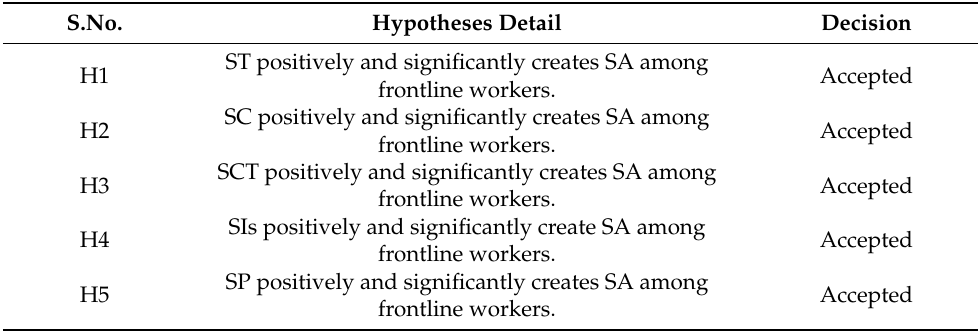
Table 5. Summary of Decisions on